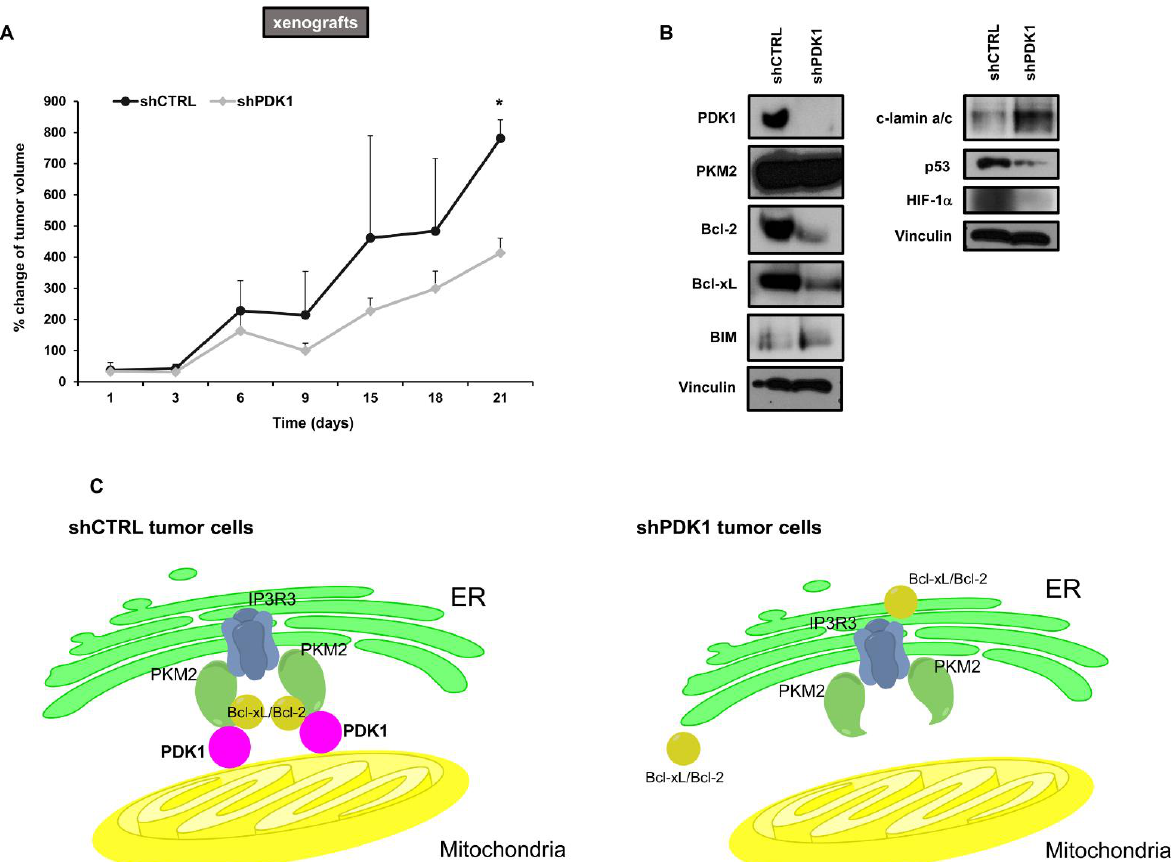
Figure 6. Effects of PDK1 knockdown on tumor growth and levels of selected proteins in surgically excised tumors. ( A ) Tumor volume of H1993 shCTRL and shPDK1 xenografts measured over time. The symbol * indicates statistically significant difference versus shCTRL at 21 days with * p < 0.05. ( B ) Western blot analysis of whole lysates from surgically excised xenografts showing levels of Bcl-2 family proteins, p53 and HIF-1α. Vinculin served to ensure equal loading. ( C ) Schematic representation of the PDK1-dependent assembly of macromolecular complexes involving PKM2 and Bcl-2/Bcl-xL at the ER–mitochondria interface. The uncropped Western Blot images can be found in Figure S25.